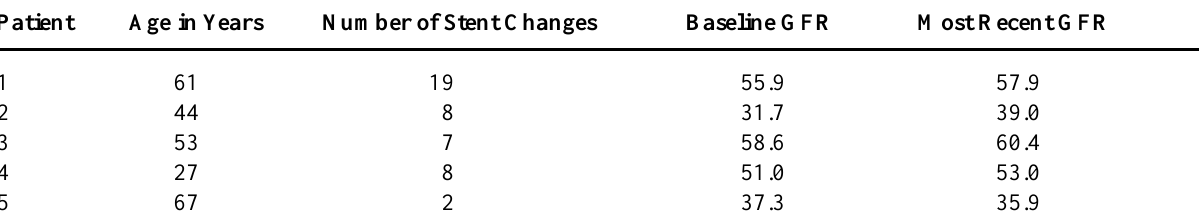
Table 1 – Demographics and maintenance of glomerular filtration rates (GFR) in patients with renal allograft ureteral obstruction managed with chronic ureteral